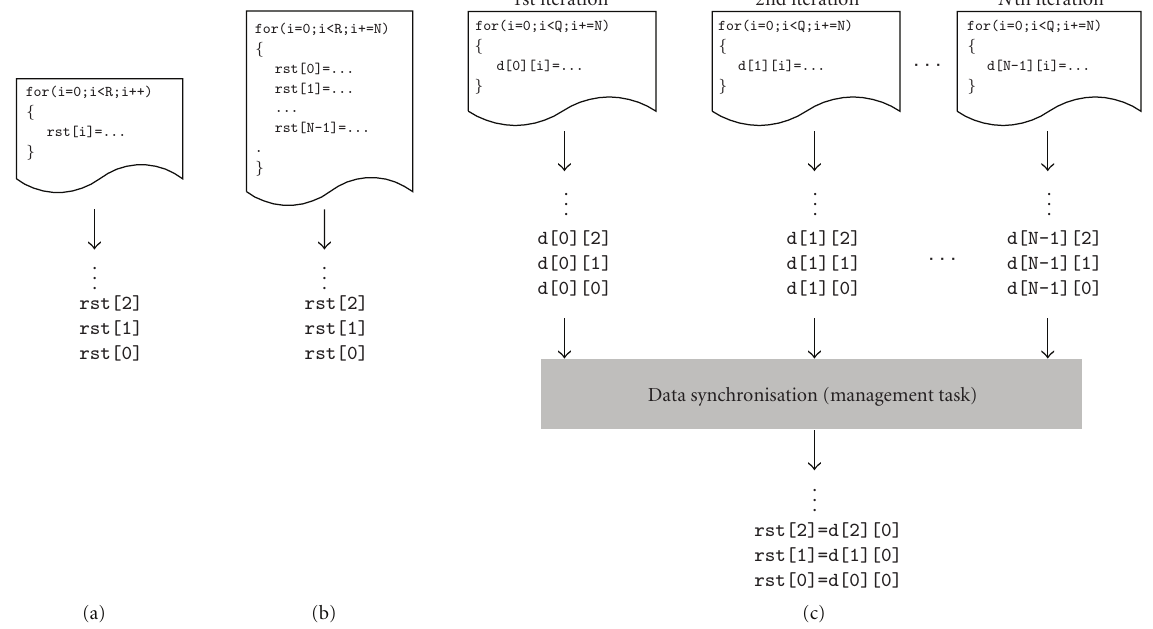
Figure 5: Data synchronisation after unrolling and fission. (a) Original loop. (b) Unrolled loop. (c) Generated sub-loops after fission.